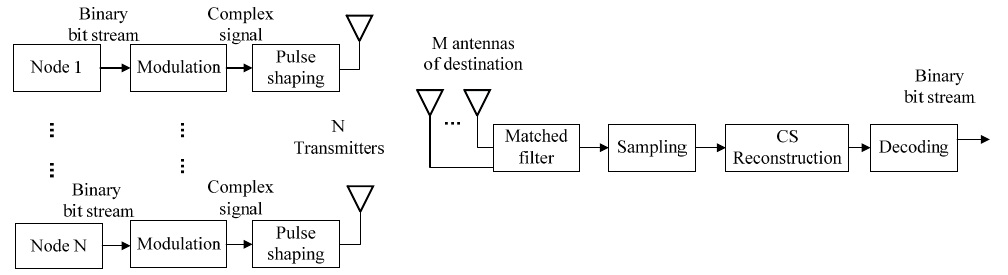
Figure 2. The structure of sensor nodes and destination.